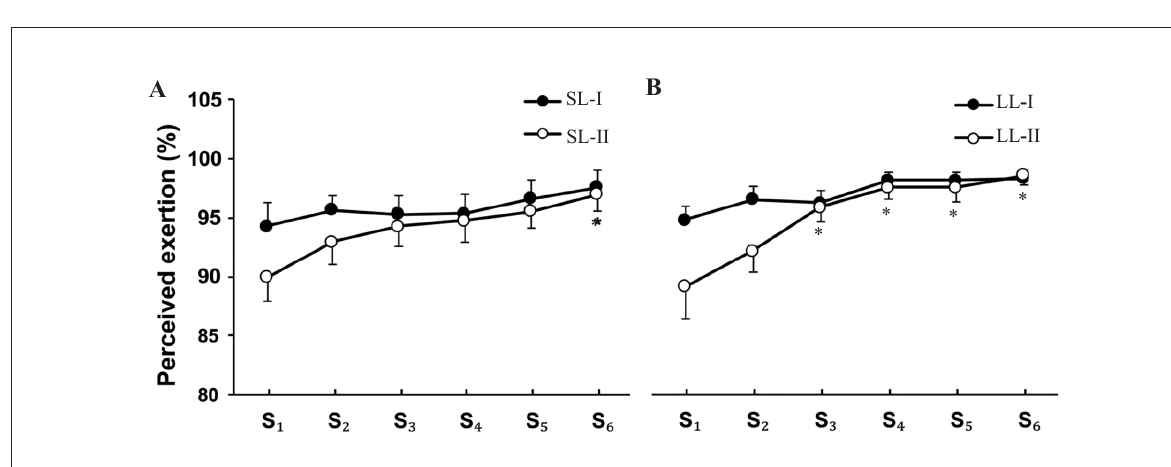
Figure 6. The modified Rating of Perceived Exertion Scale results after each series of sustained maximal (uni-)bilateral